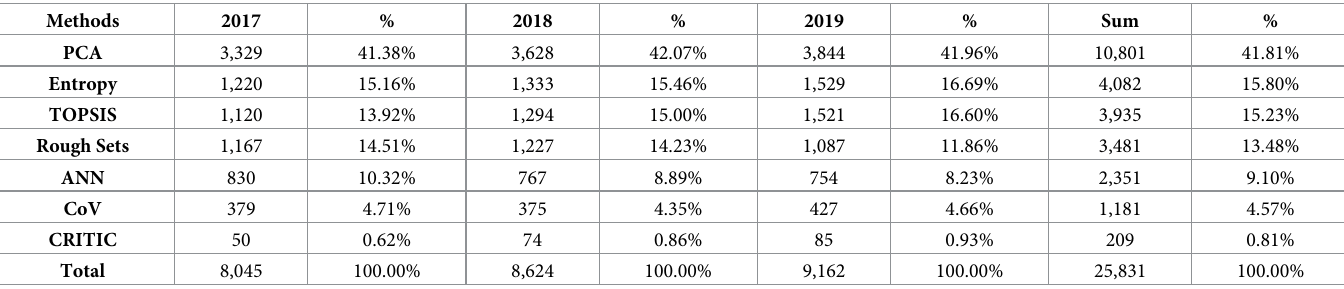
Table 1. Objective methods in publications between 2017 and